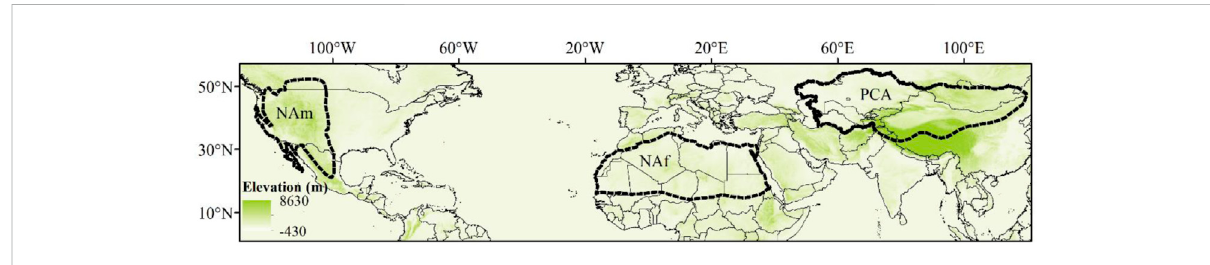
FIGURE 1 Three typical arid regions of the Northern Hemisphere.